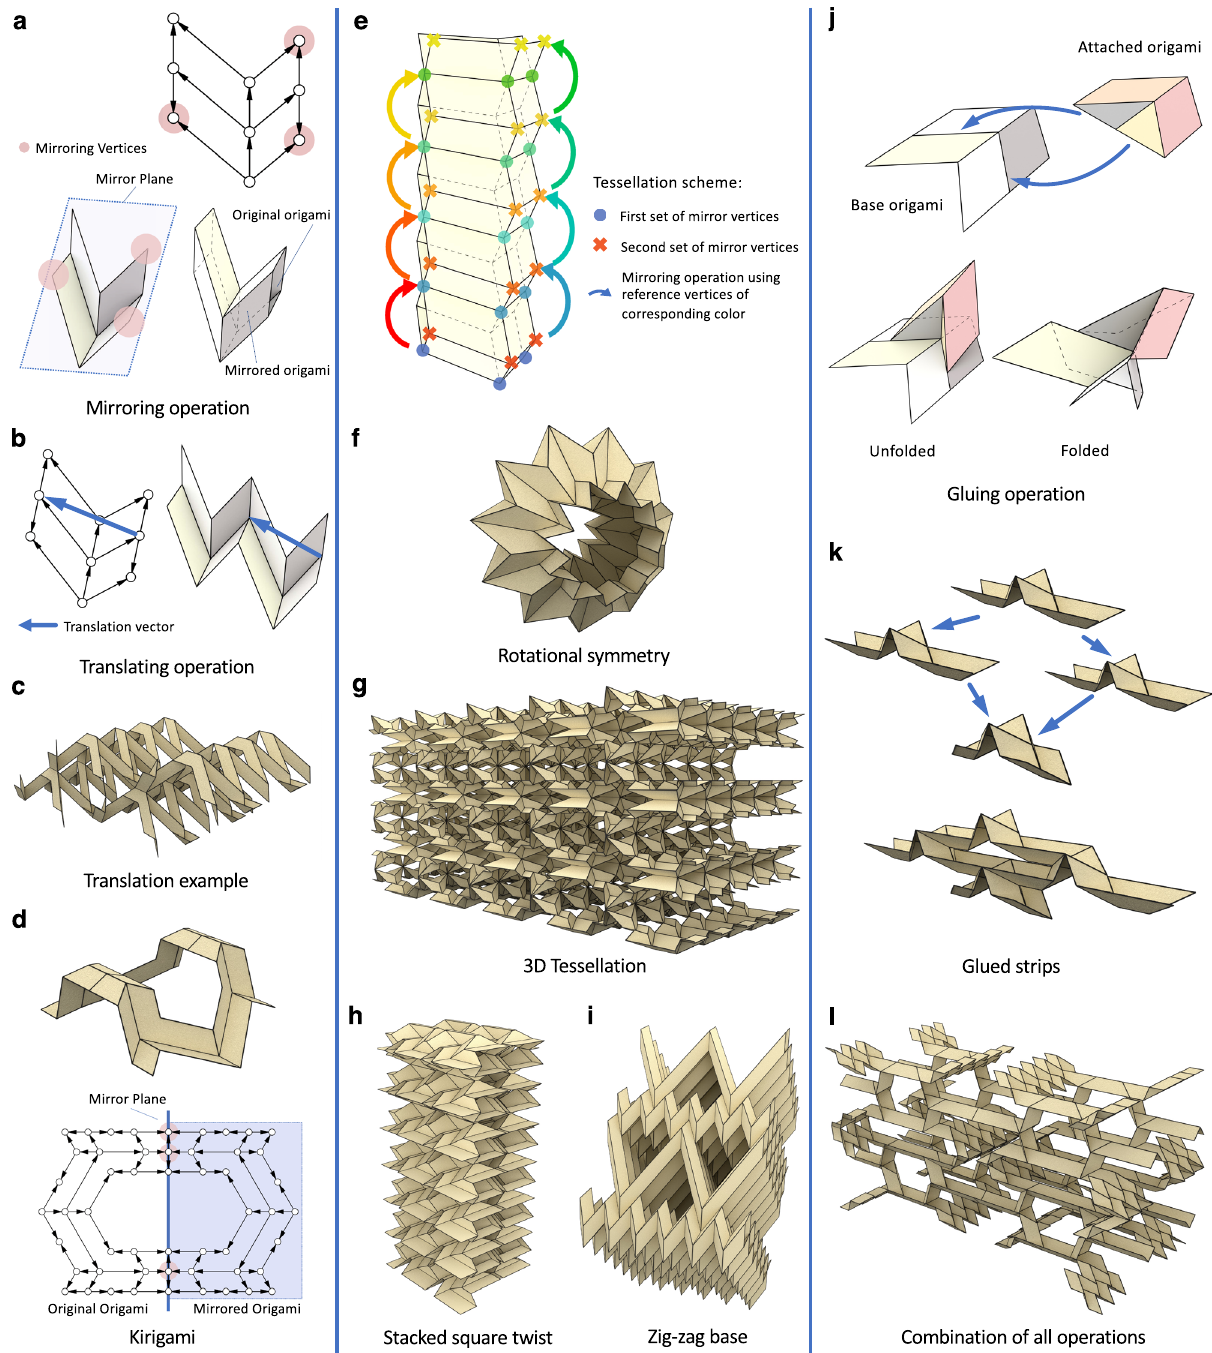
Fig. 4 Mirroring, translating, and gluing of crease patterns. a Mirroring operation. Crease pattern graph (auxiliary vertices shown) with marked mirror vertices and folded con fi guration of corresponding crease pattern before and after the application of the mirror operation. b Translating operation. Crease pattern graph (with auxiliary vertices) with marked translation vector (de fi ned by the two connected vertices) and folded con fi guration after application of the translation operation. c Example structure obtained by translating operation. d Example (kirigami) structure obtained by mirroring operation where the mirror vertices form a line. e Scheme to tessellate patterns using the mirroring operation. f Example structure obtained with scheme in Fig. 4e with non- parallel mirror planes. g Example structure obtained by applying the scheme in Fig. 4e in two directions. h Structure obtained by applying the scheme in Fig. 4e on the square twist pattern. i Tessellation obtained by repeated application of the mirroring and translating operation. The structure belongs to a well-documented family 4 . j Gluing operation. Unfolded con fi guration of two crease patterns before application of the operation, unfolded and folded con fi guration after application of the gluing operation. k Example structure obtained by repeated application of the gluing operation. l Example structure obtained by the application of quadrilateral-closing, mirroring and gluing